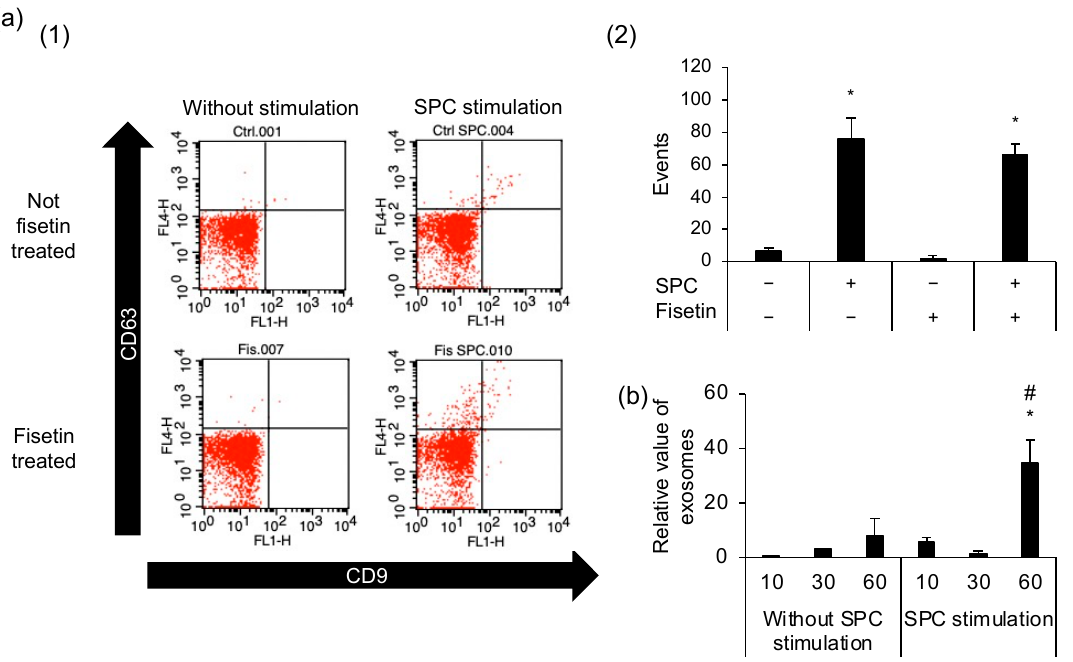
Figure 5. The number of exosomes in human coronary artery smooth muscle cells (HCASMCs). ( a ) (1) Flow cytometric dot plots representing CD9- and CD63-positive populations. (2) Number of exosomes generated from control (Ctrl) cells and fisetin-treated cells. ( b ) Number of exosomes in HCASMCs relative to unstimulated Ctrl cells. * p < 0.05 vs. Ctrl without stimulation. # p < 0.05 vs. without sphingosylphosphorylcholine (SPC) stimulation at the same time. Data are expressed as mean ± standard deviation.